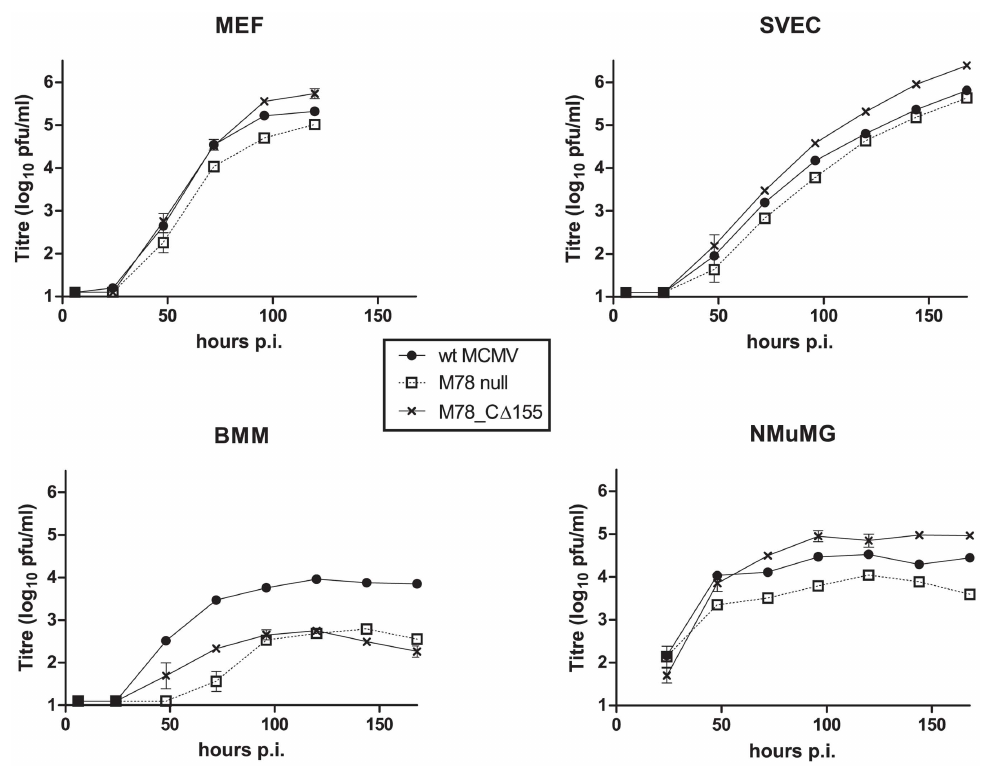
Fig 5. Effects of M78 mutation upon replication kinetics in different cell types. Multi-step growth curves of wild type (wt), M78_null and M78_ C Δ 155 in fibroblast (MEF), endothelial(SVEC), epithelial(NMuMG) and macrophage(BMM) cell types. Cells were infected in 24 well trays at low multiplicity (0.01 pfu/cell) and supernatantharvested at various times post-infection for titration of infectious virus by plaqueassay (mean and standard error shown; n = 3). Statistical significance was determined via 2-way ANOVA with Bonferroni post-test and is reported in the